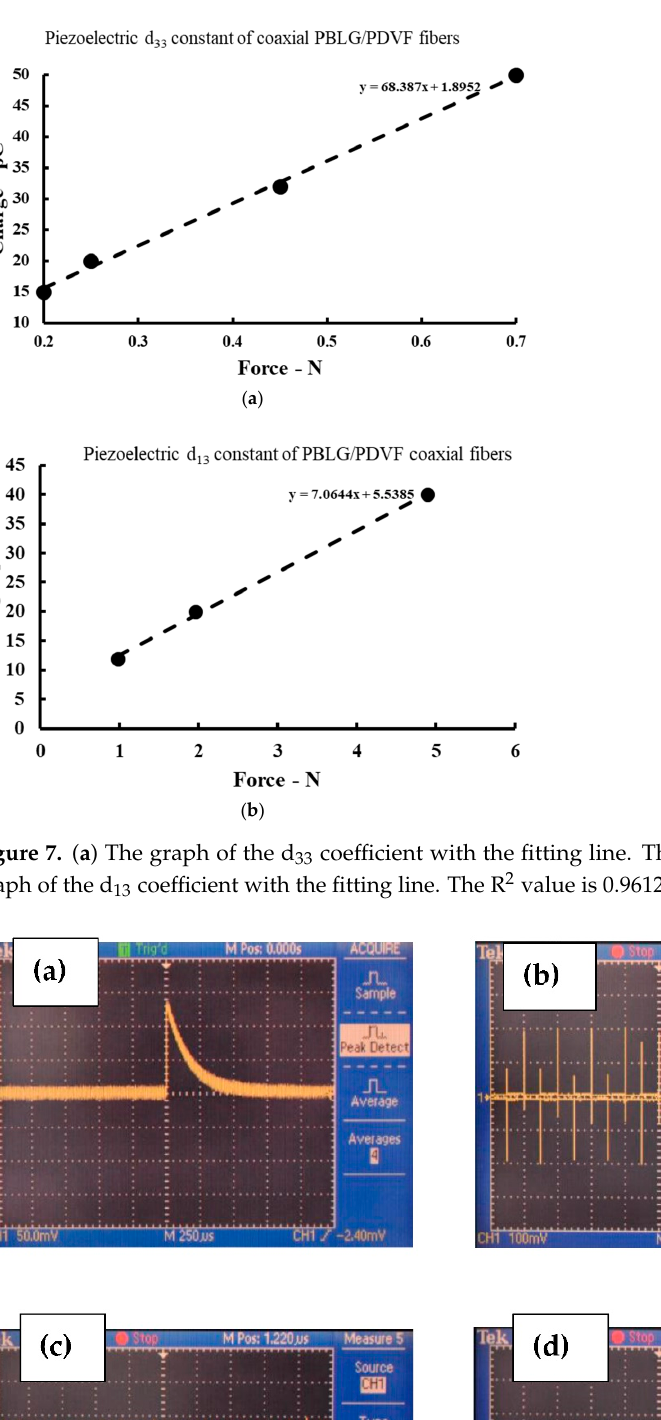
Figure 9. The force applied ( a ) by a sine shape form along the fiber axes and ( b ) charge generation in time domain.